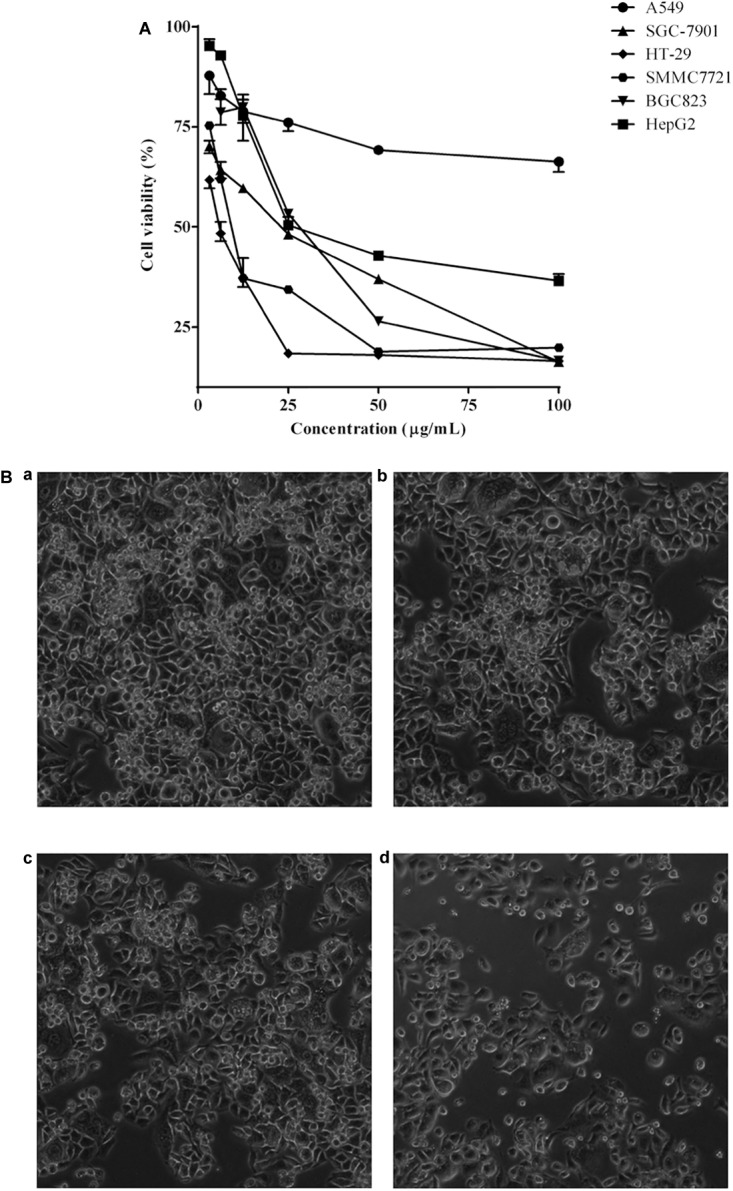
(A) Cytotoxic effects of DCMPI on the A549, SGC-7901, HT-29, SMMC7721, BGC-823 and HepG2 cell lines as determined by the MTT assay for 72 h. (B) Microscopic observation of HT-29 cells after administrating DCMPI for 72 h (a): untreated; (b): treated with 12.5 μg/mL DCMPI; (c): treated with 25 μg/mL DCMPI; (d): treated with 50 μg/mL DCMPI).